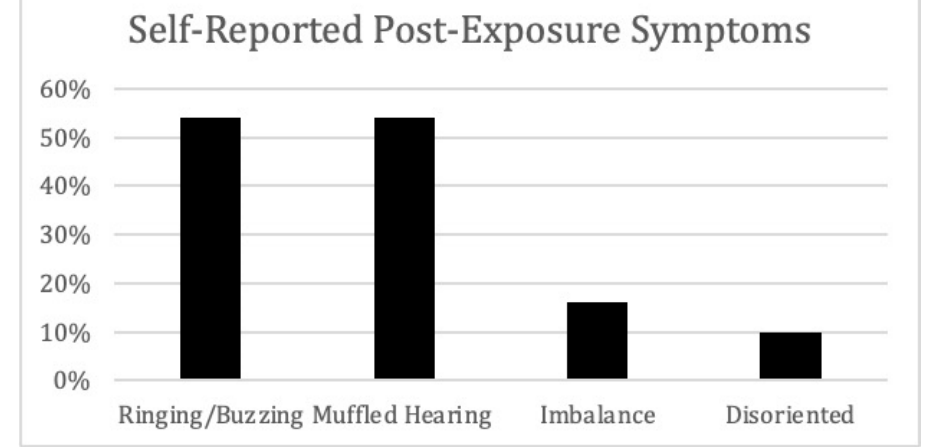
Figure 1. Percent of self-reported post exposure symptoms.